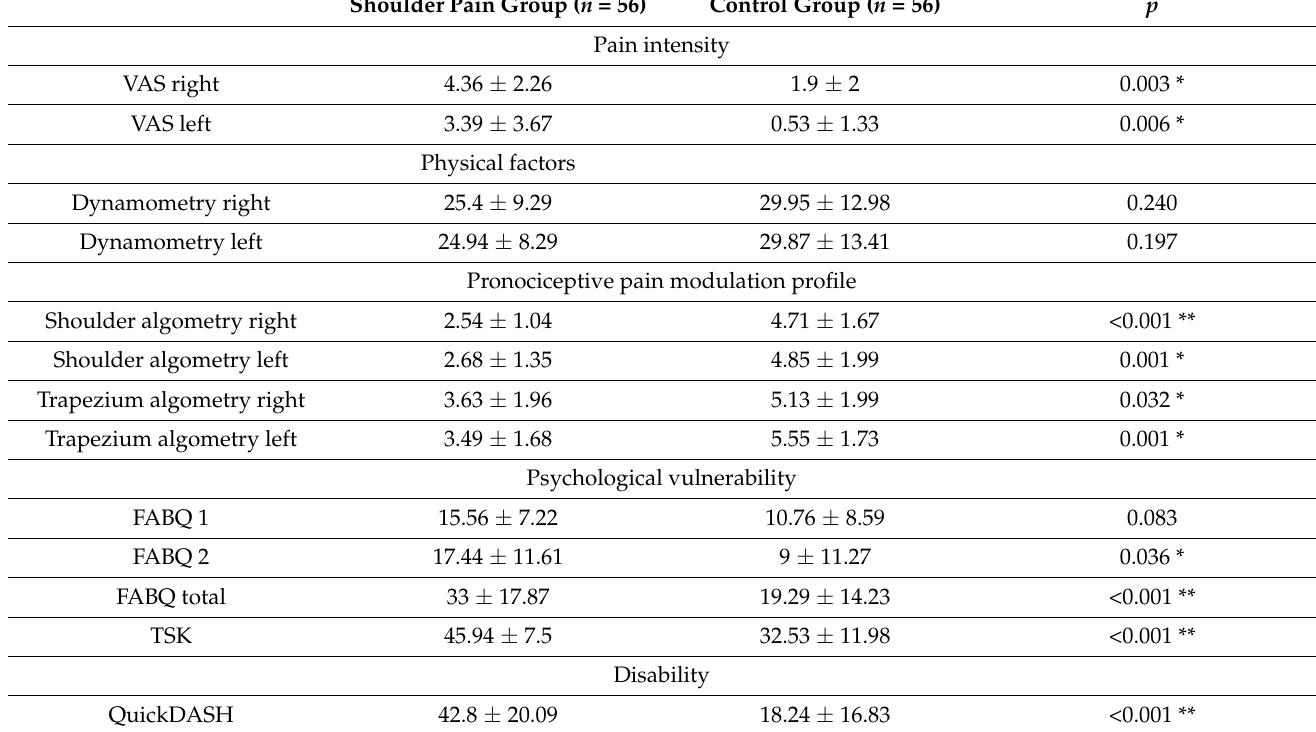
Table 2. Differences between groups in physical factors, pronociceptive pain profile, psychological vulnerability and